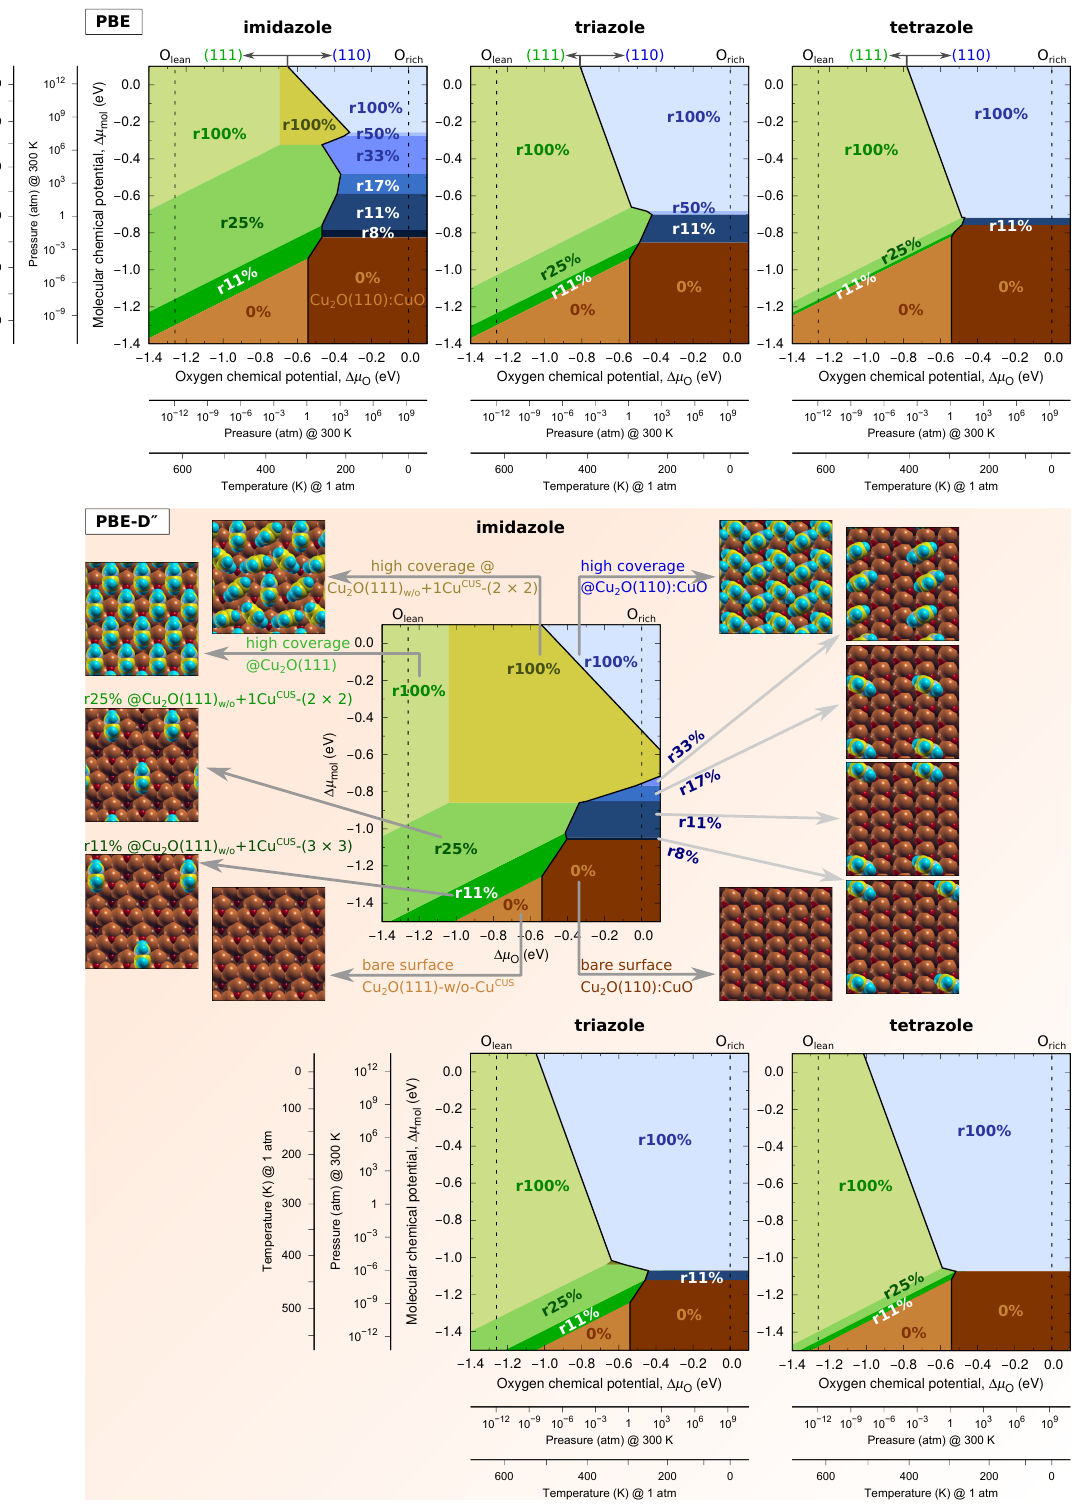
Figure 8. As in Figure 7, but in addition to Cu 2 O(111)-type surfaces also the Cu 2 O(110):CuO surface is considered. Notice that Cu 2 O(111)-type structures appear on the left part of phase diagrams, whereas Cu 2 O(110):CuO structures appear on the right. Top-view snapshots and naming of structures that appear on the phase diagrams are shown for